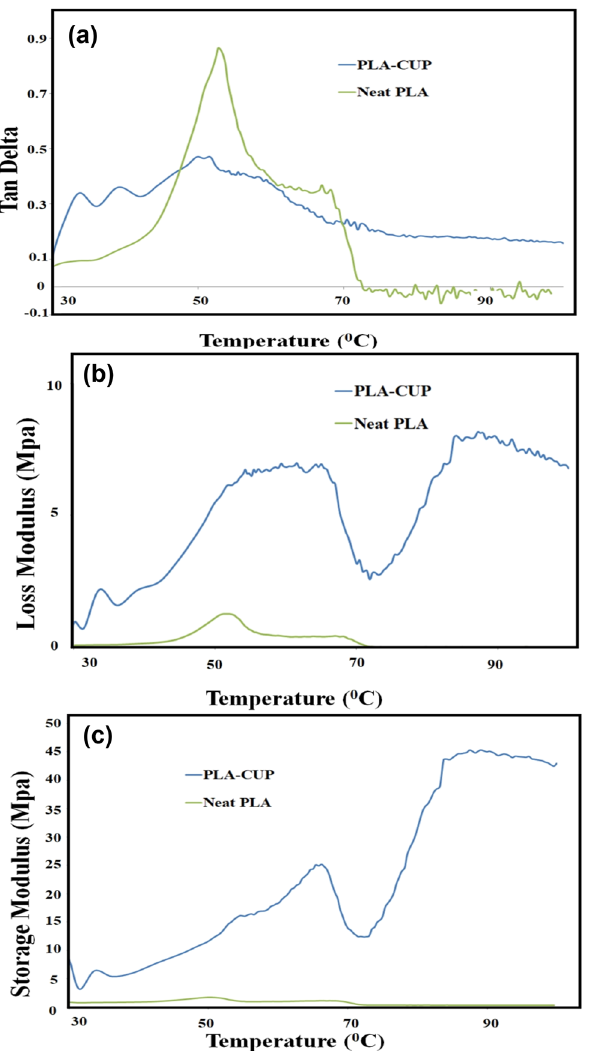
Figure 4: Thermal properties ( a ) Tan Delta, ( b ) Loss Modukus, ( c ) Storage Modulus of the neat PLA and the 15% EO added PLA - CUP nano fi bers.